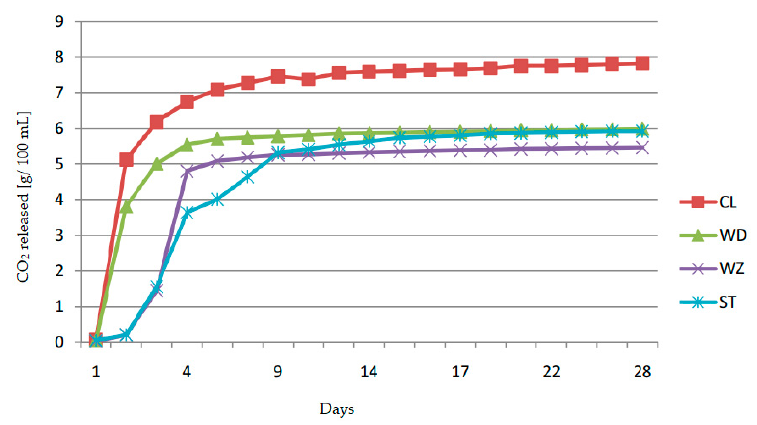
Figure 2. Fermentation dynamics of plum must fermented with S. cerevisiae S1, n = 5, STD < 5%. Abbreviations: CL— Č a č anska Lepotica, WD—W ę gierka D ą browicka, WZ—W ę gierka Zwyk ł a, ST—Stanley.